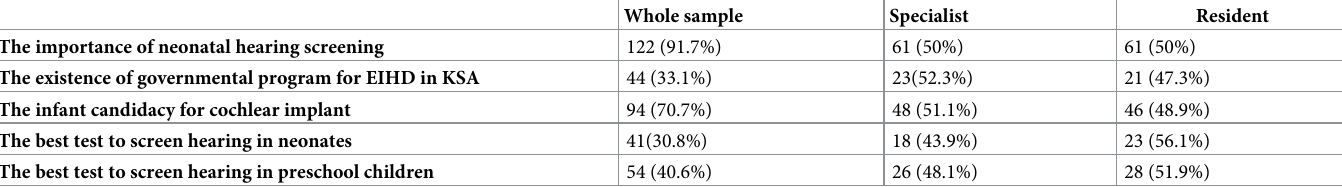
Table 3. The percentage of family physician correctly answered the information related to hearing screening and management.